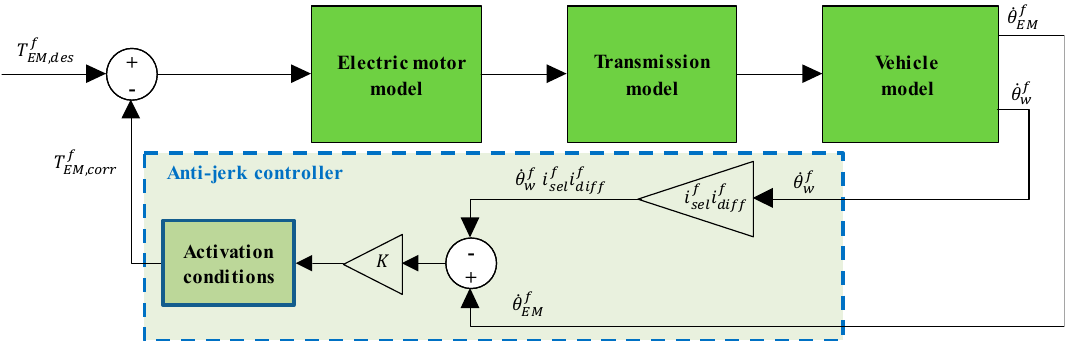
Figure 7. Simplified block diagram of the vehicle system with the implemented anti-jerk controller.